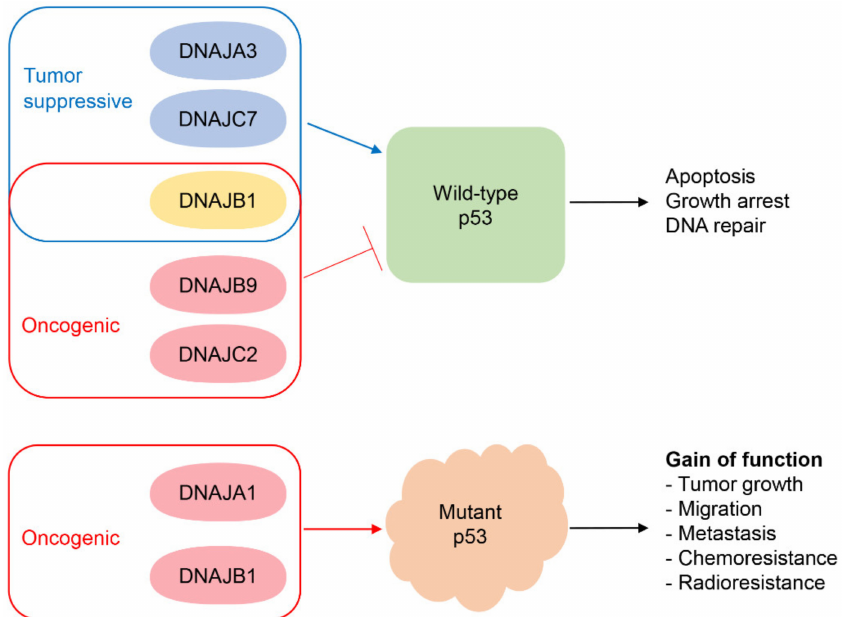
Figure 2. Regulation of wtp53 and mutp53 functions by HSP40/JDPs. DNAJA3 and DNAJC7 cooperate with wtp53 to enhance the tumor suppressive activity, while DNAJB9 and DNAJC2 have tumor-promoting functions by inhibiting the wtp53 activity. DNAJB1 can inhibit or enhance the wtp53 activity, likely depending on the cellular context and/or cancer type. DNAJA1 and DNAJB1 interact with mutp53 and contribute to the levels and activity of GOF